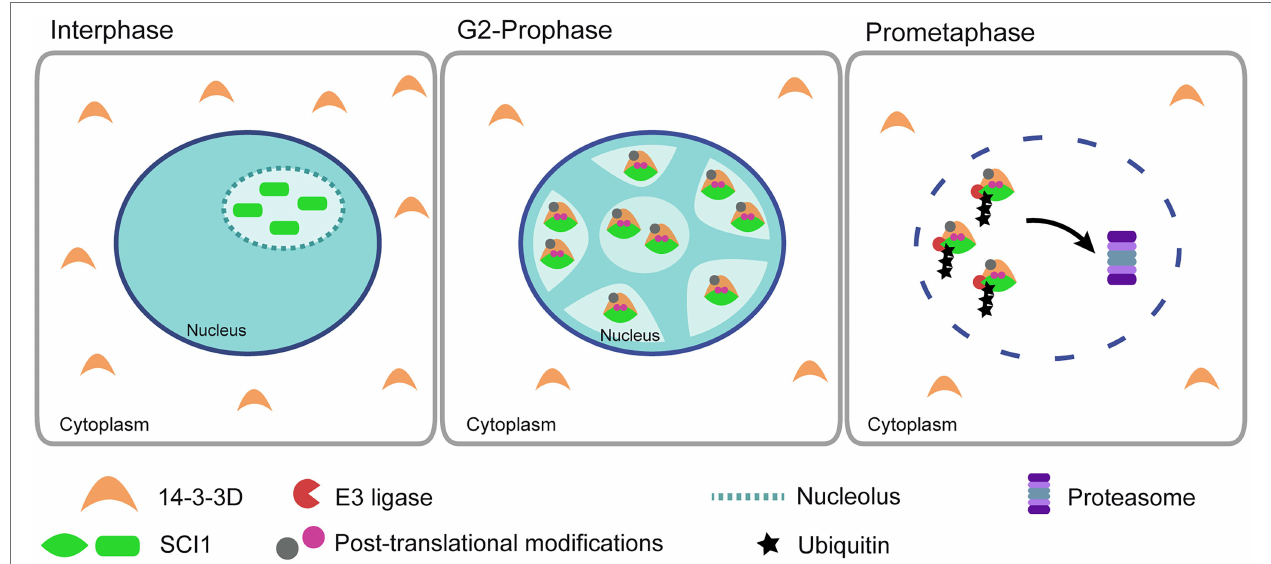
FIGURE 7 | A proposed model illustrates the interaction of SCI1 and 14-3-3D during early mitosis. During interphase (DAPI staining, in blue, is well spread in the nucleus), SCI1 is in the nucleolus, and 14-3-3D is in the cytoplasm. Signals to start cell division promote the movement of 14-3-3D to the nucleus. In parallel, cell division signals cause SCI1 post-translational modifications (possibly phosphorylation by a still unknown kinase). At G2/prophase, chromatin is starting its condensation (shown in blue), and SCI1 and 14-3-3D interact at the nucleoplasm. At prometaphase, 14-3-3D mediates SCI1 26S proteasome degradation, which allows cell division to